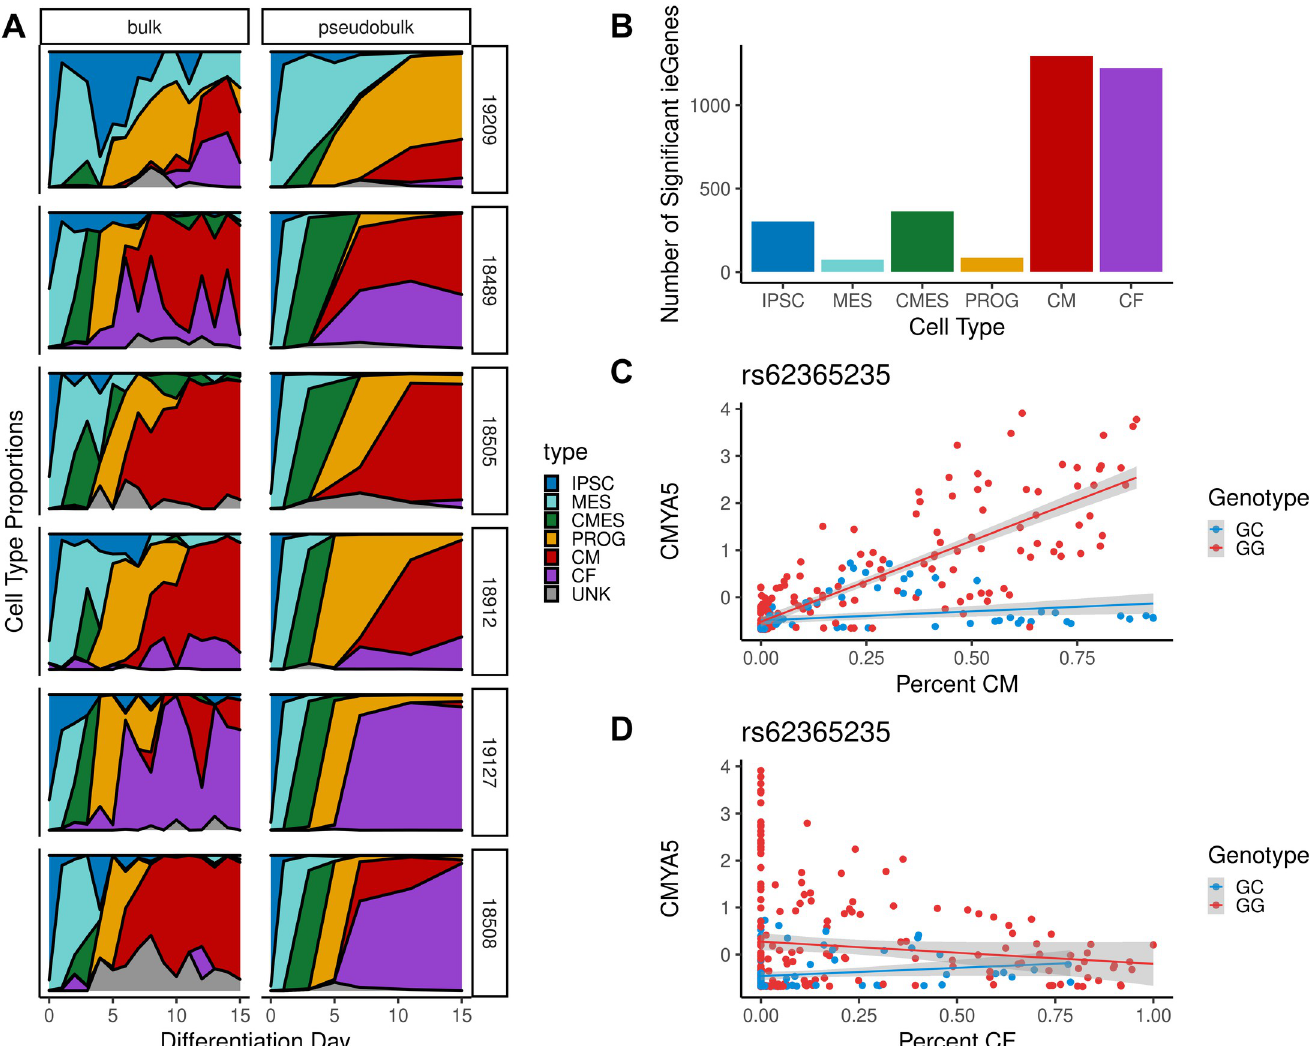
Fig 4. Cell type deconvolution and interaction eQTL calling. (A) Cell type deconvolution was applied to decompose RNA expression of a mixed sample, aggregated over multiple cell types, into its constituent cell type proportions (Materials and Methods). Each row represents a cell line, collected in two separate experiments. In the left column, bulk RNA-sequencing data was collected for 15 timepoints (time on x-axis). In the right column, pseudobulk was aggregated across cells collected for 7 time points (time on x-axis). For pseudobulk data, deconvolution is not needed, as each cell is assigned to a cell type. Thus, "ground truth" cell type fractions are accessible as reflected here. (B) Number of genes with a cell type interaction eQTL in bulk for each of six cell types. (C-D) CMYA5 has an interaction eQTL for the cardiomyocyte lineage (C) that is not identified in the cardiac fibroblast lineage (D).